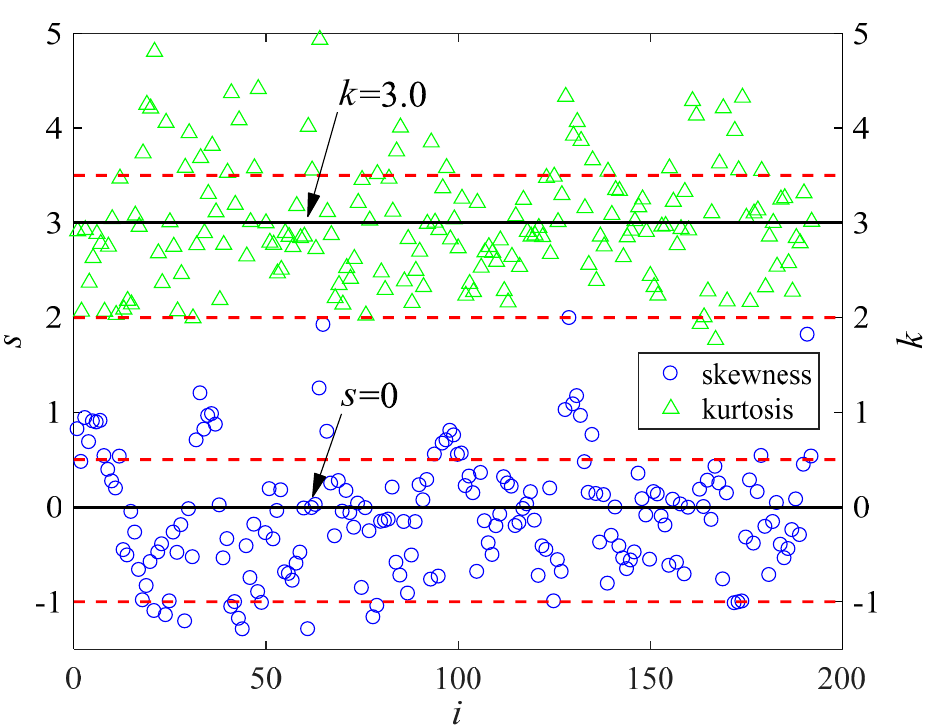
Figure 32. Skewness and kurtosis statistics of the net wind pressure coefficients for all measuring points at a 45° wind direction angle.